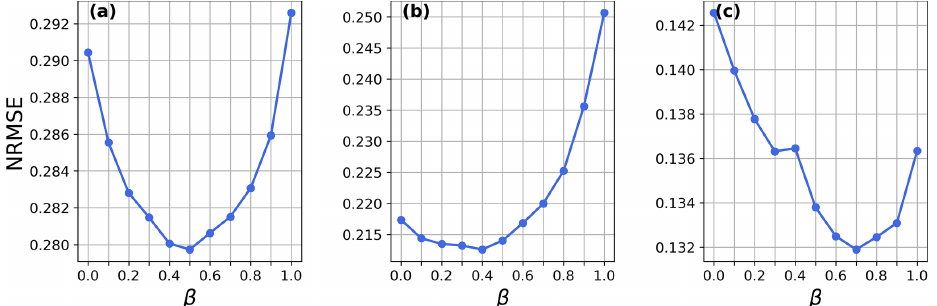
Figure 2. The NRMSE averaged over the summer period without (a) and with (b) the assimilation of radar QPEs and over the winter (c) for the different β